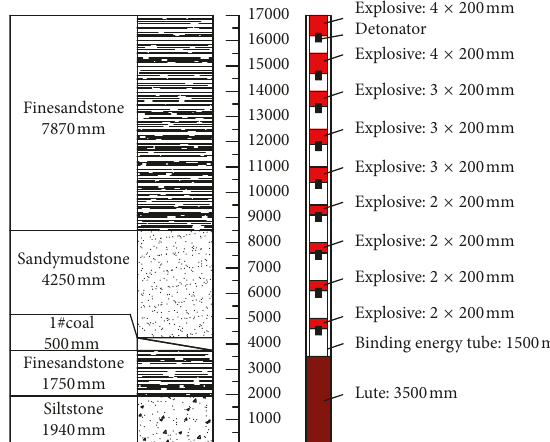
Figure 16: The optimum volume of